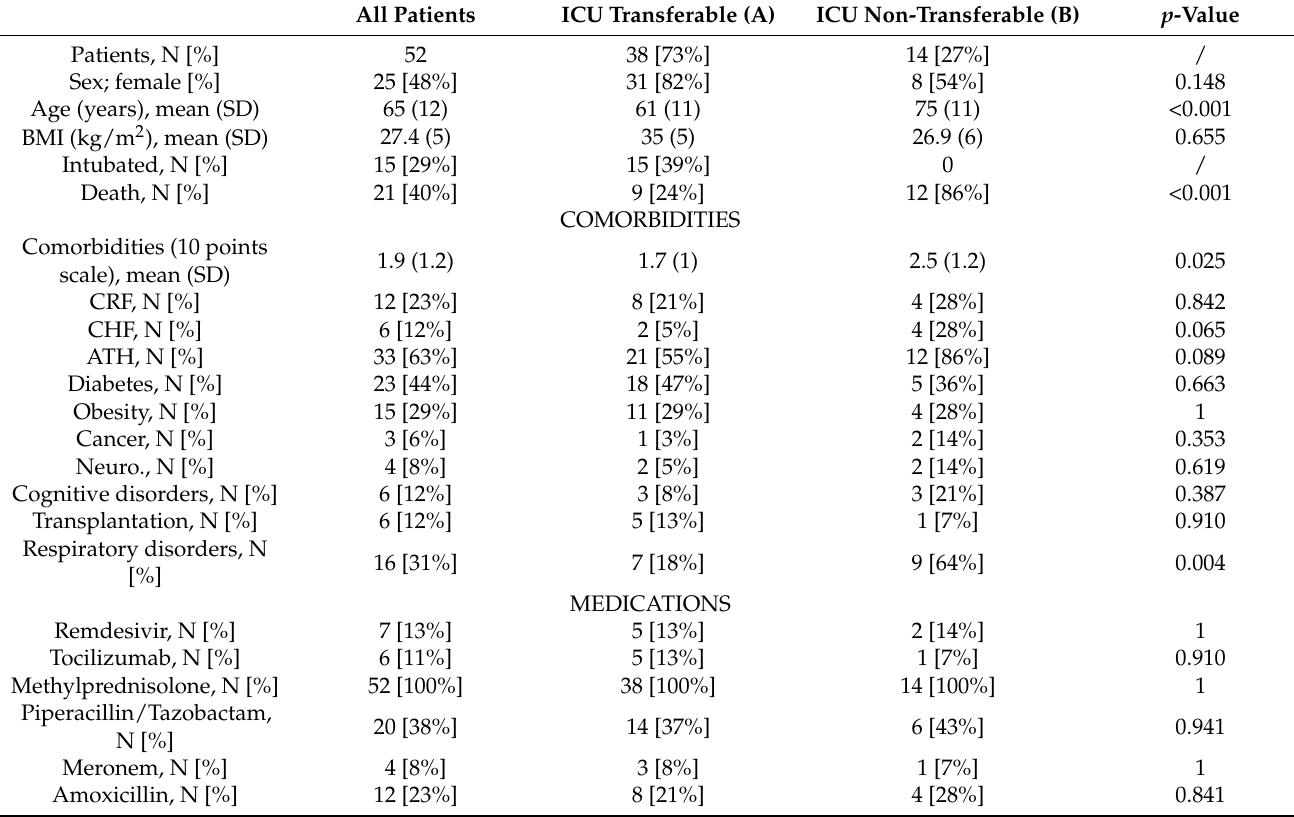
Table 1. Characteristics of transferable to ICU versus not transferable to ICU